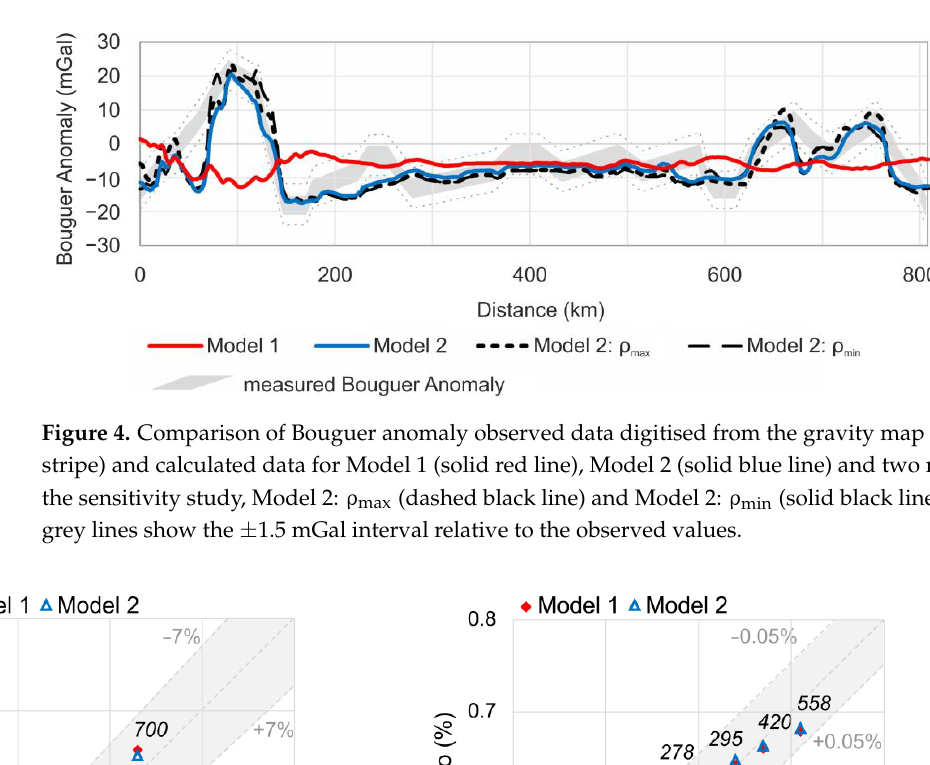
Figure 5. Calibration results of present-day measured and modelled ( a ) temperatures and ( b ) vitrinite reflectance by the EasyRo kinetic model [73]. Italic numbers near the data points correspond to the wellbore location (in km) along the pro- file. Grey zones show the area of ±7% for temperature and ±0.05% (absolute) for vitrinite reflectance. The final geological section is presented in Model 1 in in Figure 6a.